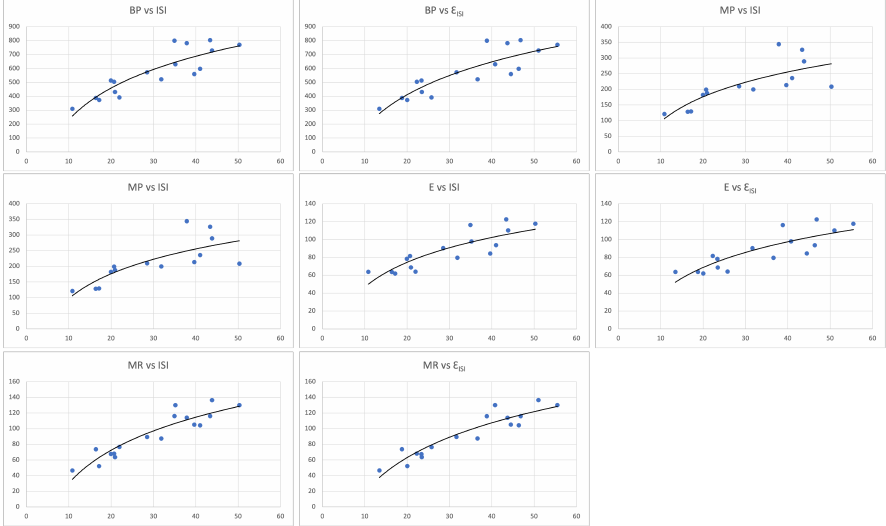
Figure 3. Logarithmic Regression for Physical Property with the ISI -index and E ISI of Anticancer